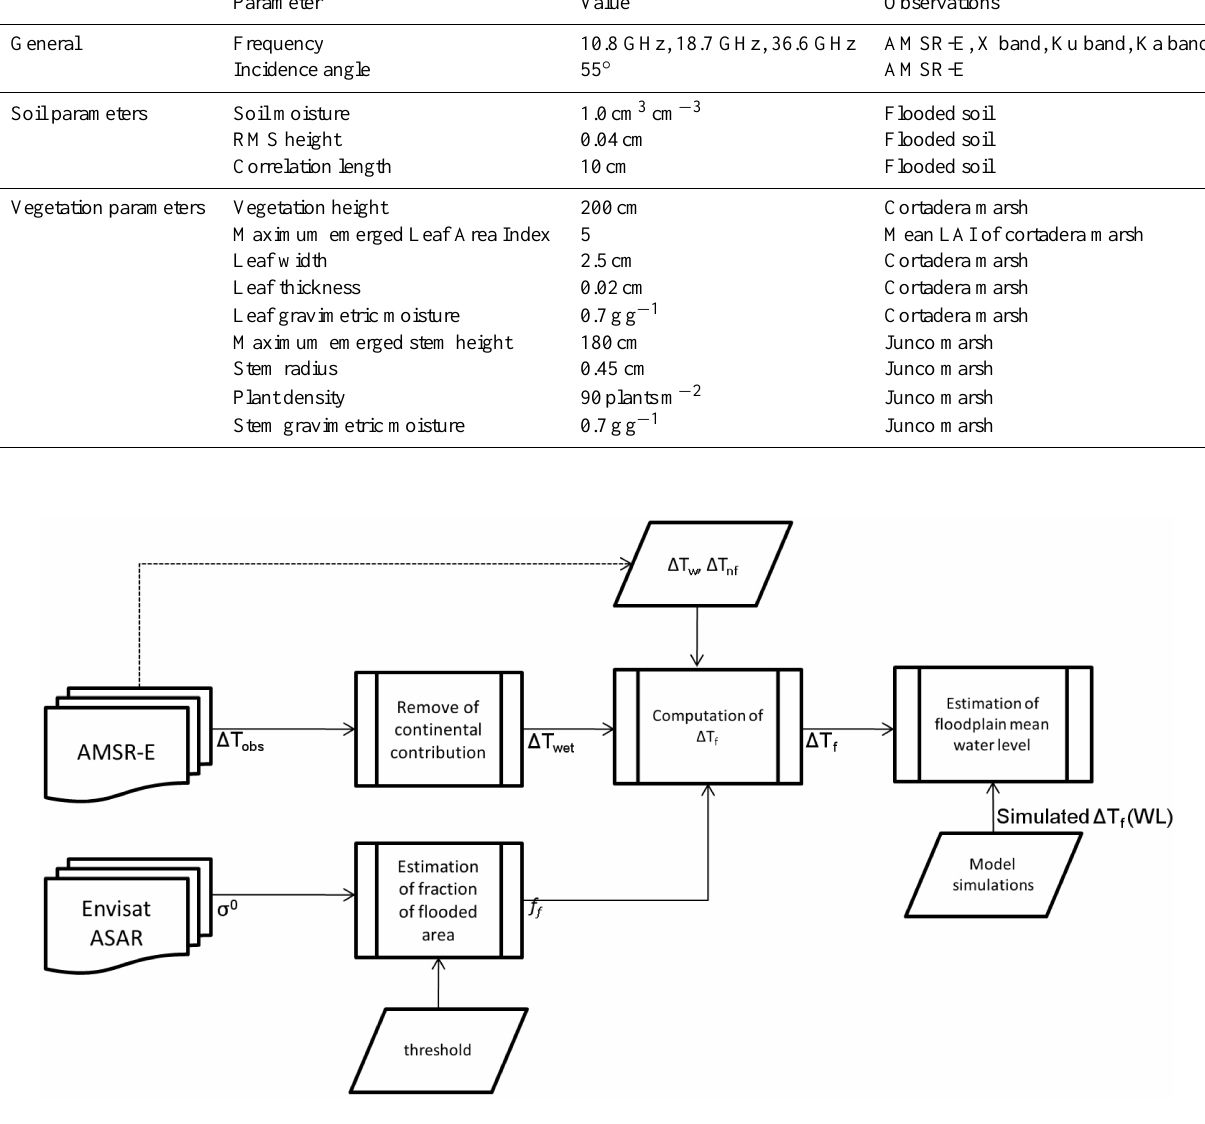
Fig. 5. Flow diagram of the methodology